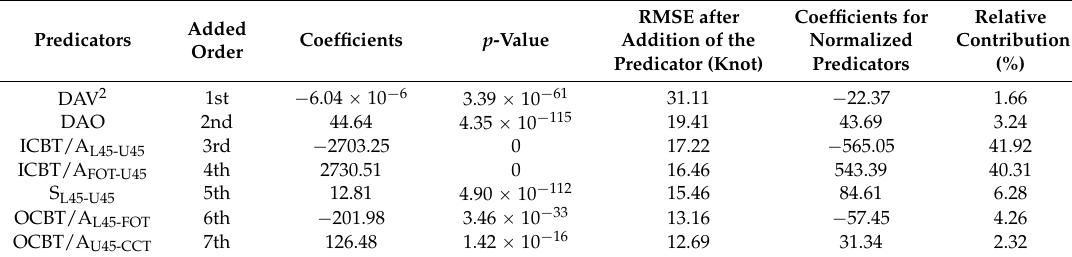
Table 3. Statistics related to the regression